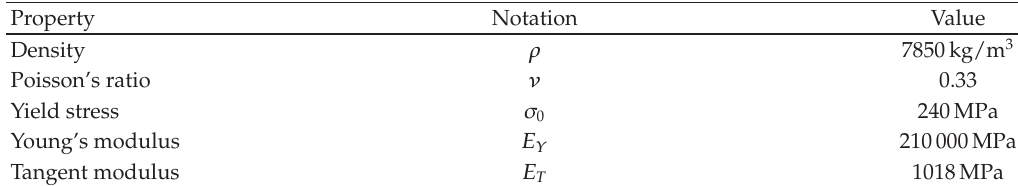
Table 4: Useful properties for defining the material law of